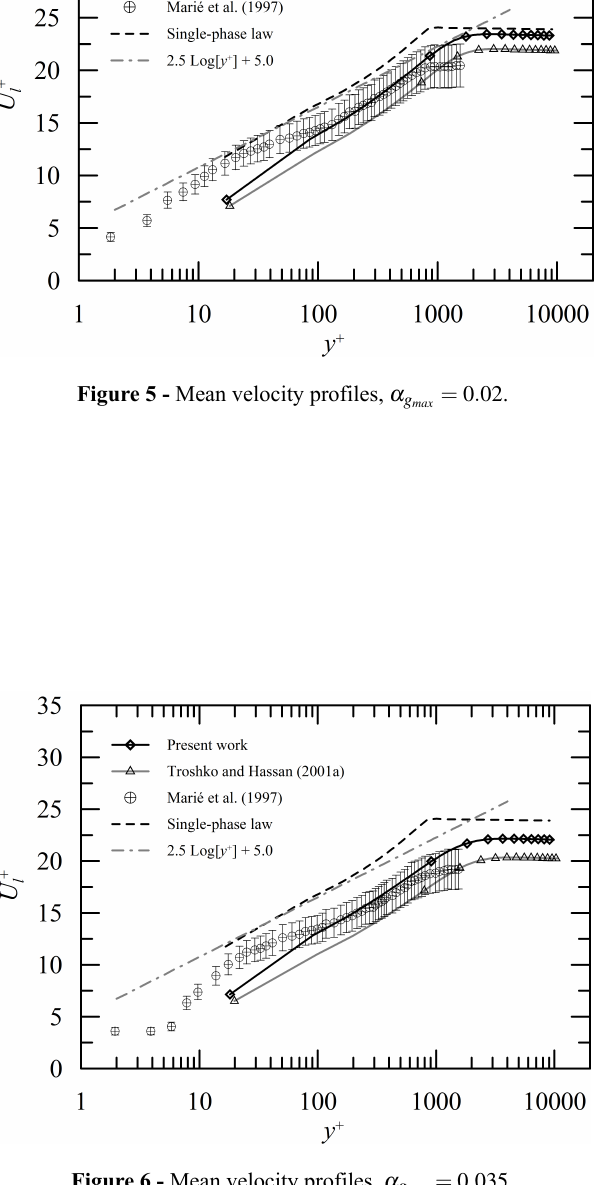
Figure 6 - Mean velocity profiles, α g